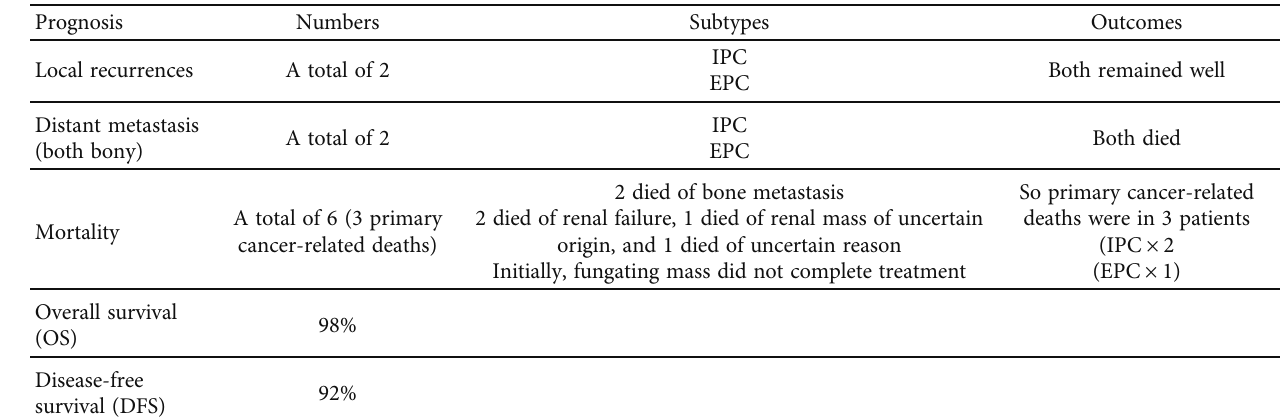
Table 3: Recurrences and survival in four types.